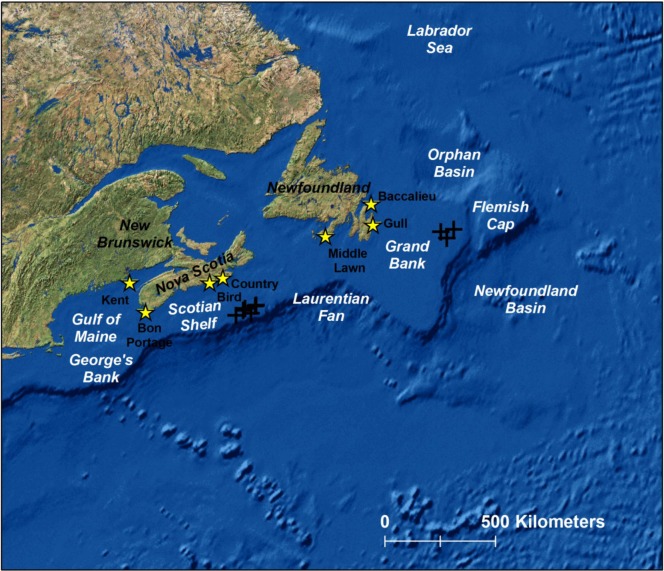
Study area.Eastern Canadian colonies from which Leach’s storm-petrels were tracked in 2013 and 2014 (yellow stars) along with oil and gas production platforms (+). Also indicated are place names mentioned in the text.